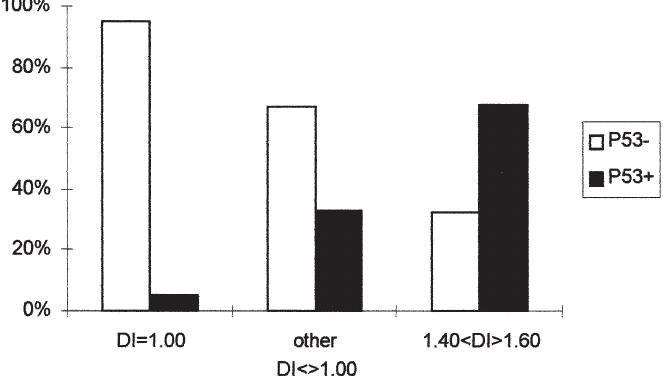
Fig. 7. Bar histogram showing the relation existing between DI classes and P53 immunohistochemical expression. Note the increasing % of cases with high expression of P53 in the DNA near-triploid class (DI = 1 . 5 ± 0 . 1) in comparison with the other DI